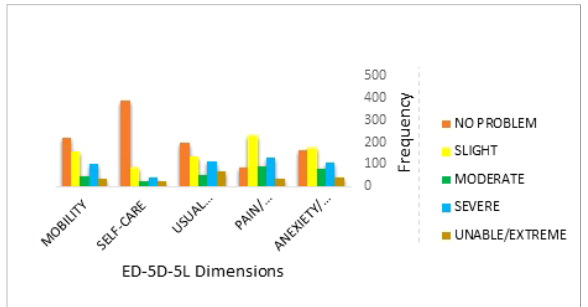
FIGURE 1 Distribution of problems reported on each EQ-5D-5L